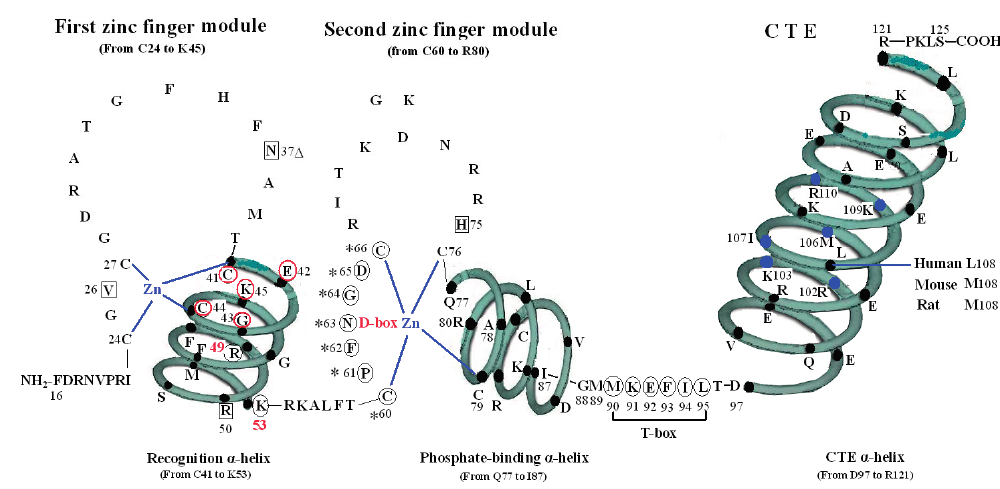
Figure 1. Structure of DNA-binding domain of the vitamin D receptor (VDR DBD) of human, mouse and rat. The amino acid sequences of VDR DBD of human, mouse and rat extend from residues 16 to 125 and are almost exactly the same except for L108 of human and M108 of rat and mouse. The VDR DBD consists of two zinc finger structures and a C-terminal extension (CTE). Three green three-dimensional spiral patterns show three α -helices in the VDR DBD. The solid dots within α -helices represent corresponding amino acids. Four boxes: P-box (from C41 to K45); S-box (R49 and K53); D-box ( * ) (from C60 to C66); and T-box (from M90 to L95). Three parts of amino acids in VDR DBD take part in forming dimerization interface for the interaction with the DBD of 9- cis retinoid X receptor (RXR). N37 and S-box (R49 and K53); T-box (from M90 to L95); and six solid blue dots